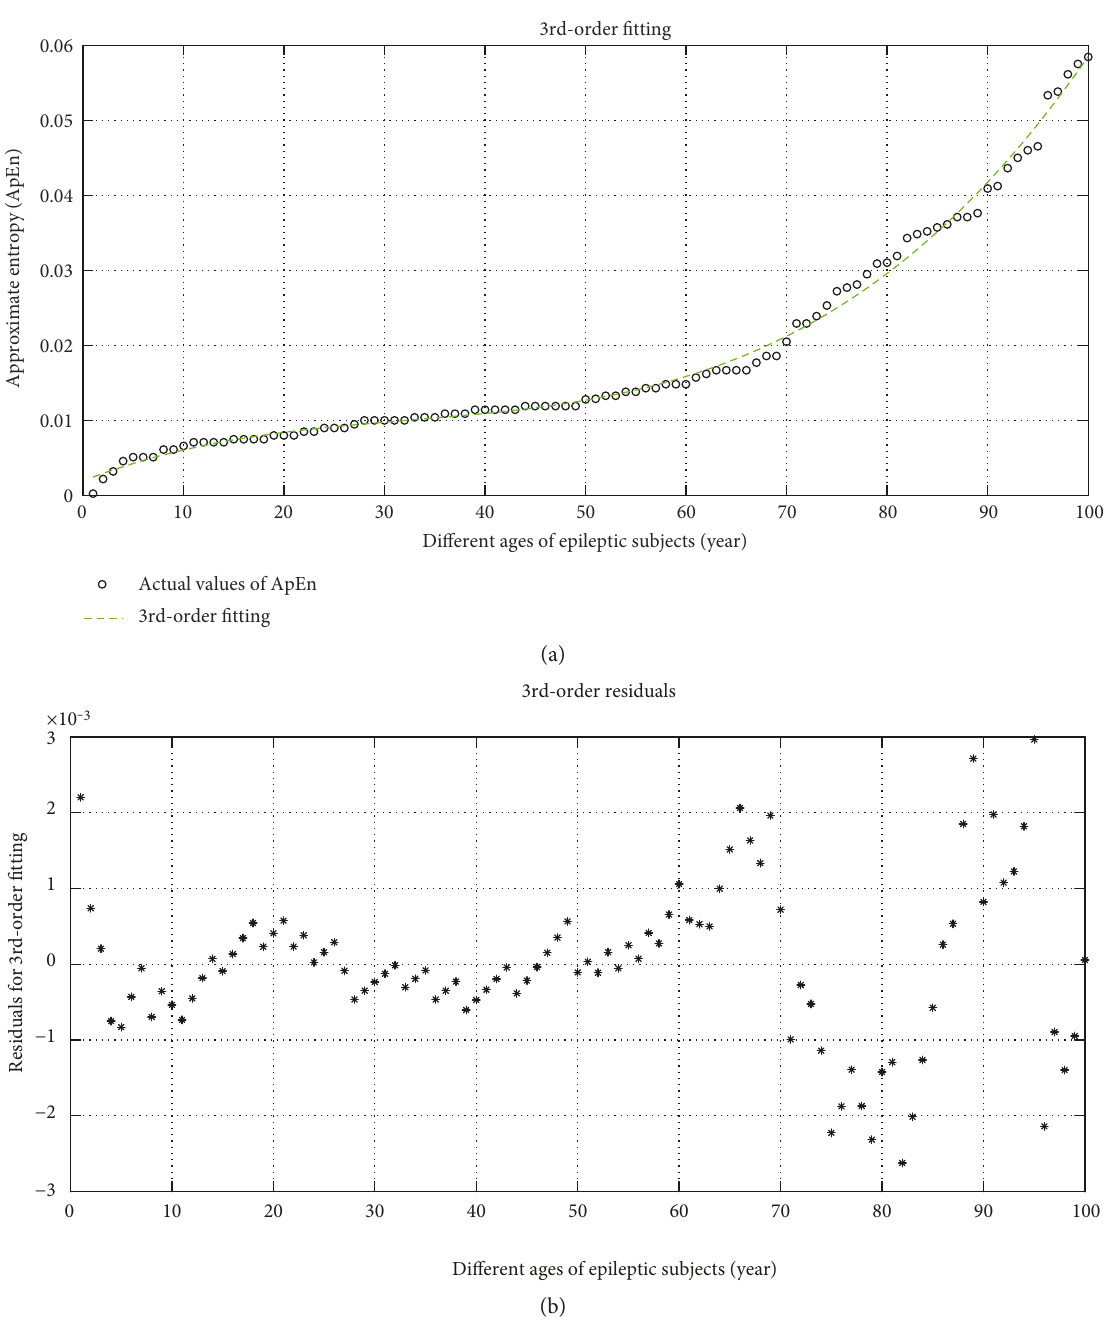
Figure 7: (a) 3rd-order fi tting and (b) residual of ApEn with di ff erent ages of